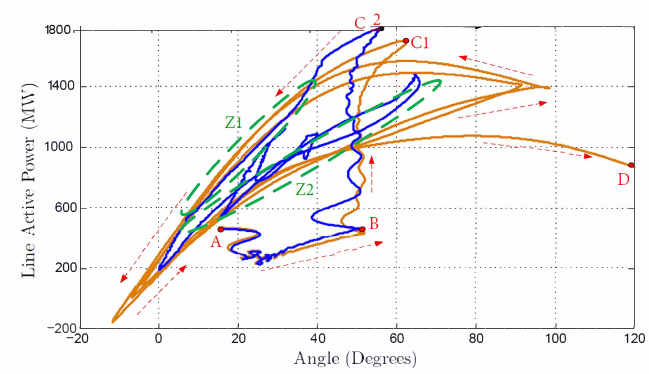
Figure 17. P- δ plot: without SVC case in orange, and delay-compensated HIL-based WAC-SVC in blue.